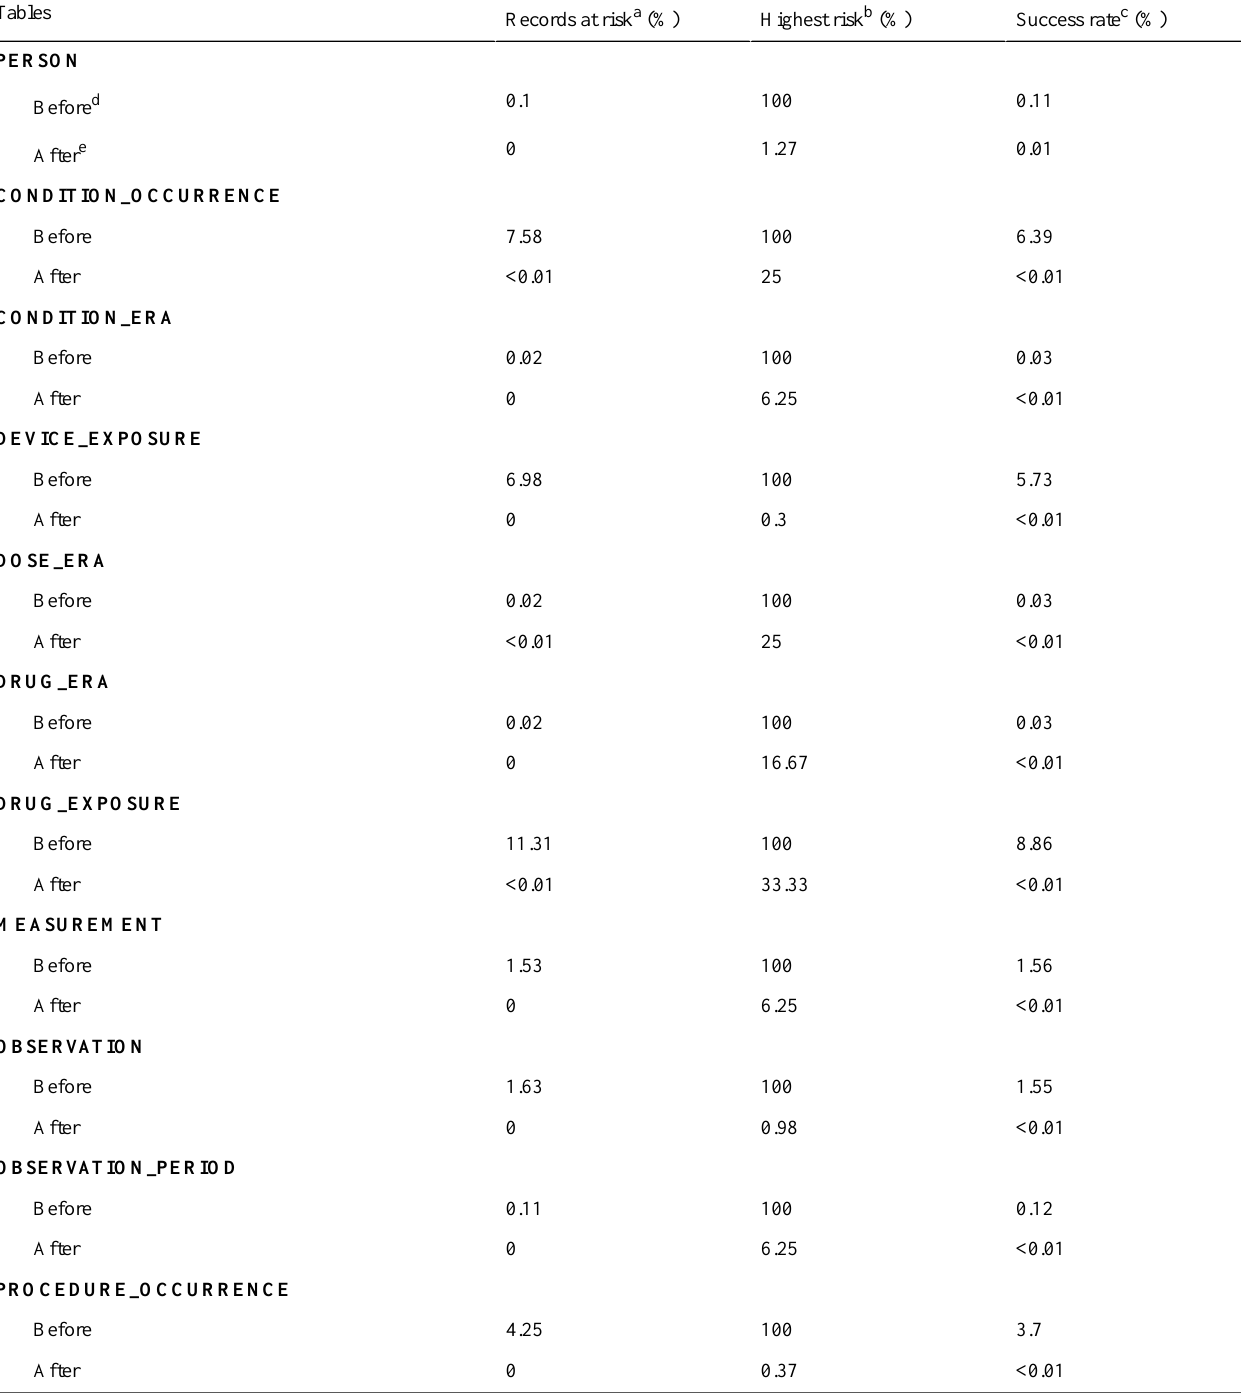
Table 3. Re-identification risks before and after source_value anonymization (k-anonymity, k =